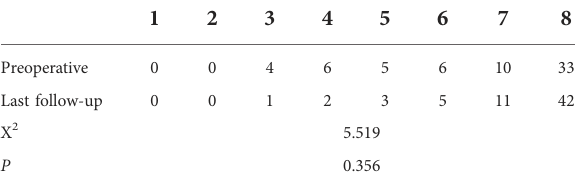
TABLE 5 Comparison of preoperative and postoperative Modi fi ed P fi rrmann Grade.